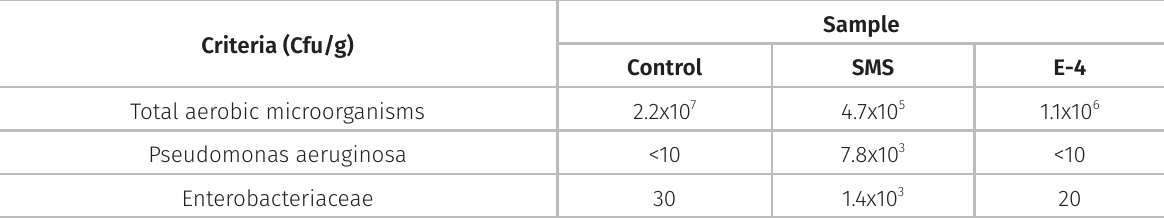
Table III. Microbiological analysis of shrimp samples after fi ve days.